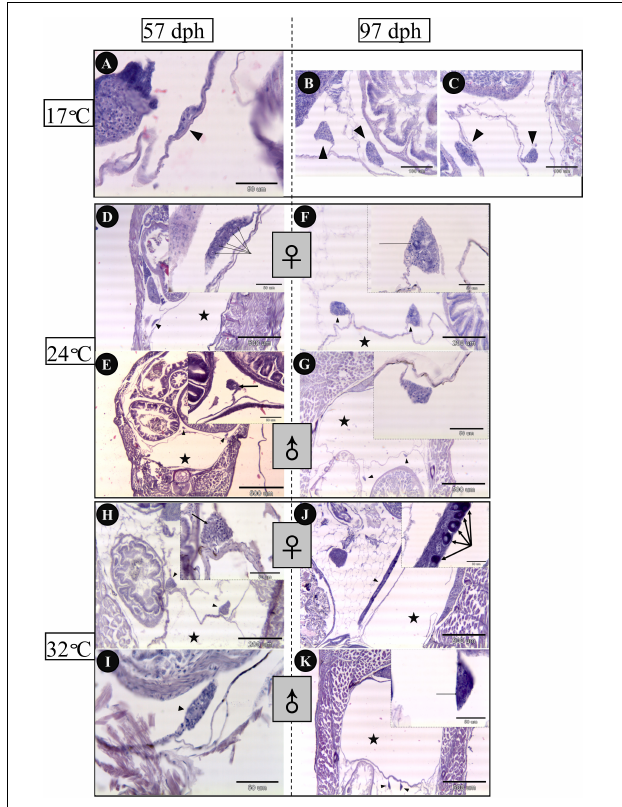
FIGURE 4 | Gonadal histology of bluegill L. macrochirus in three temperature-treatment groups (17, 24, and 32 ◦ C) at 57 and 97 days posthatching (dph). Solid triangles indicate gonads. Five-pointed stars denote the place of swim bladder. 17 ◦ C group: (A) undistinguishable gonad at 57 dph. (B,C) undistinguishable gonad at 97 dph. 24 ◦ C group: (D) presumptive ovary at 57 dph, arrows indicate several germ cells. (E) presumptive testes at 57 dph, arrow indicates germ cell. (F) ovary at 97 dph, arrow points to peri-nucleolus oocyte. (G) testes at 97 dph. 32 ◦ C group: (H) presumptive ovaries at 57 dph, arrow indicates germ cell. (I) presumptive testis at 57 dph. (J) ovary at 97 dph, arrows point to peri-nucleolus oocytes. (K) testes at 97 dph, arrow indicates germ